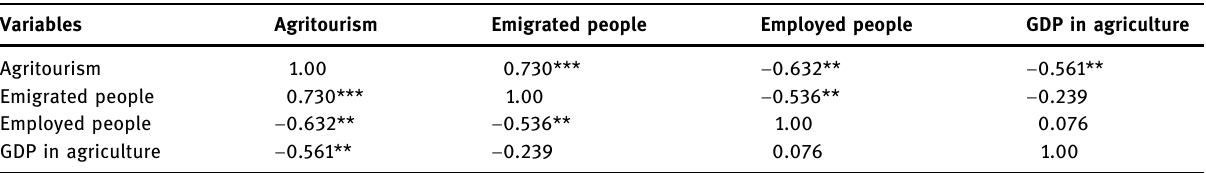
Table 1: Main correlations in some socio - economic variables and agritourism in Romania since 2000 – 2016 ( source: author ’ s own elaboration on data available at http://statistici.insse.ro )